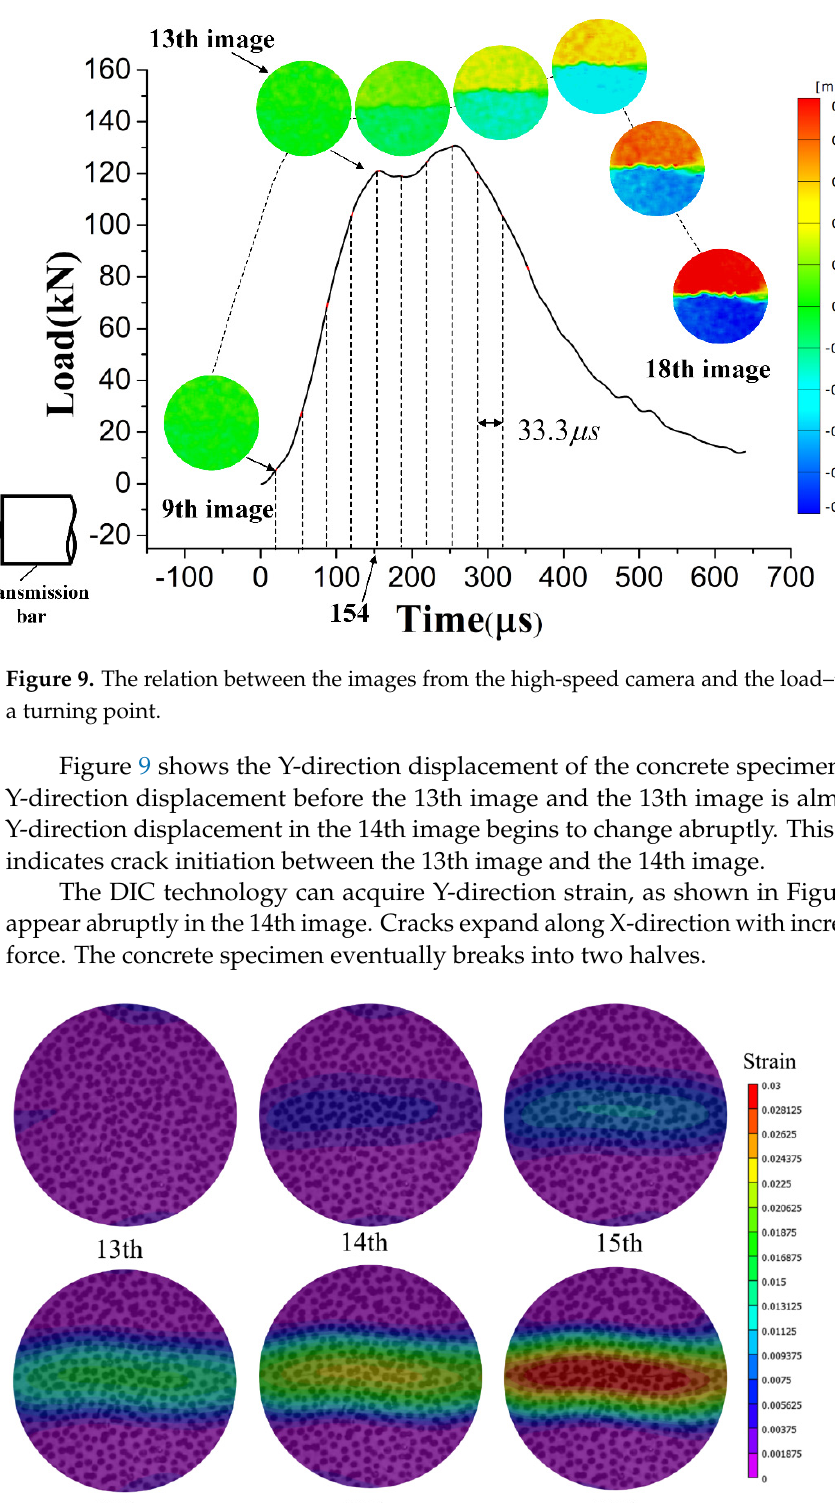
10 of 15 Figure 8. Scatter diagram of displacement change at point A and distance variation between points B and C of the specimen without a turning point in the load–time curve. 4. Results and Discussions 4.1. The Crack Evolution The DIC technology can obtain the crack evolution of concrete specimens in dynamic Brazilian disc tests. The proposed method can find the relation between the crack evolu- tion and the load–time curve. For the concrete specimen with a turning point in the load–time curve, the cracks appear at the 13.1th image according to the DIC technology, and the cracks occur at the